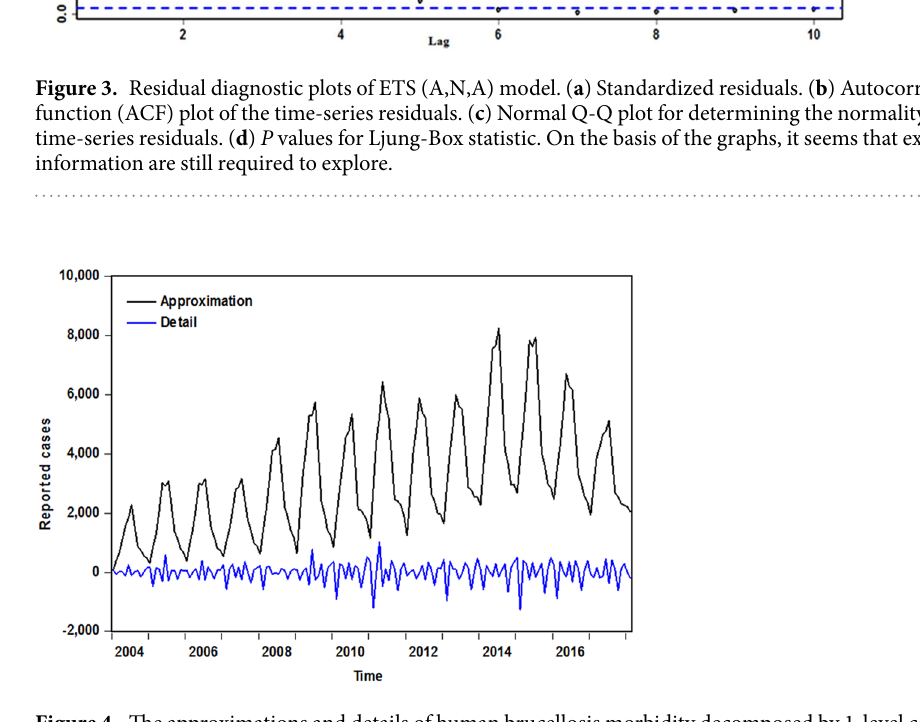
Figure 4. The approximations and details of human brucellosis morbidity decomposed by 1-level cof1 DWT. The plot demonstrates that the approximate component reserved the entire form of the human brucellosis morbidity cases time series, whereas the detailed component shows the remaining noise